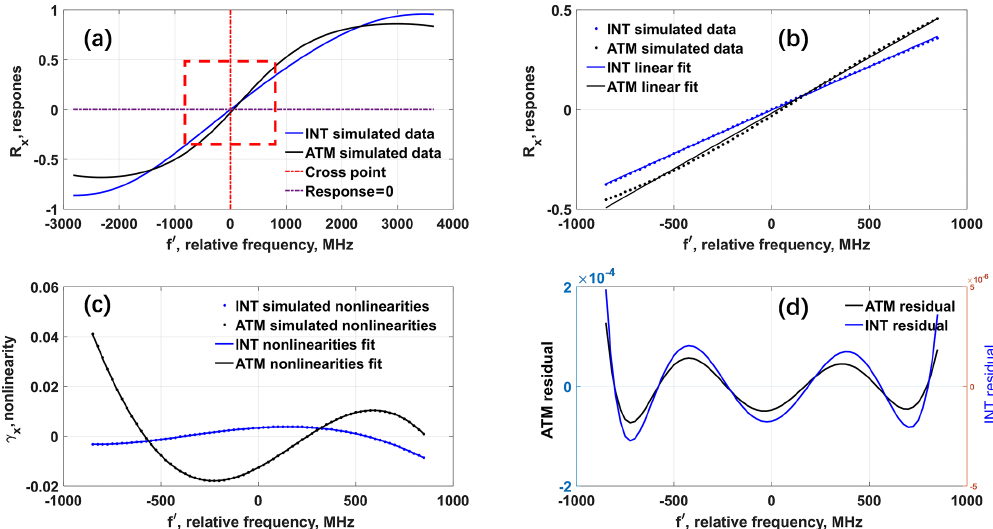
Figure 3. (a) Simulated Rayleigh response calibration (SRRC) for internal reference (INT, blue line) and atmospheric return (ATM, black line); the cross point frequency is marked by the dotted red line; (b) INT (blue dots) and ATM (black dots) response functions and corre- sponding linear least squares fits (blue line for INT, black line for ATM) over a frequency interval of ± 850MHz, where relative frequency is used instead of absolute frequency; (c) simulated nonlinearities (dots) and fifth-order polynomial fits for INT (blue line) and ATM (black line). (d) Response function residuals from INT (blue line) and ATM (black